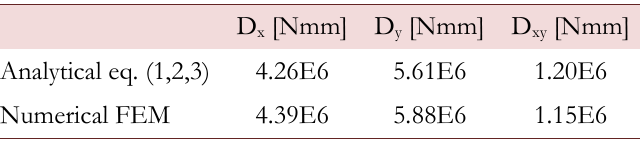
Table 2: Comparison between the analytical model and FEM